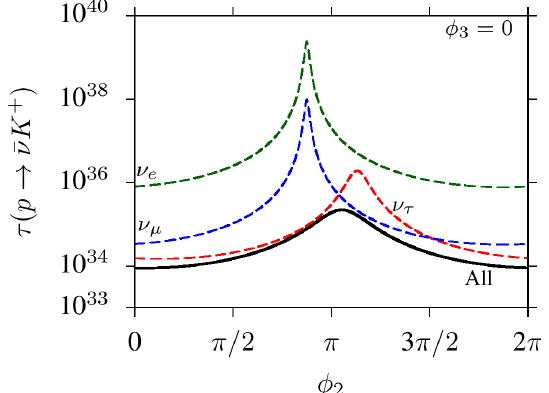
Figure 8 . Lifetime of the proton in correlation with the phase angle φ 2 with φ 3 set to zero. Green, blue and red dashed curves represent the proton decay into ν e , ν µ and ν τ along with K + , respectively. The solid curve shows the total lifetime of the proton.